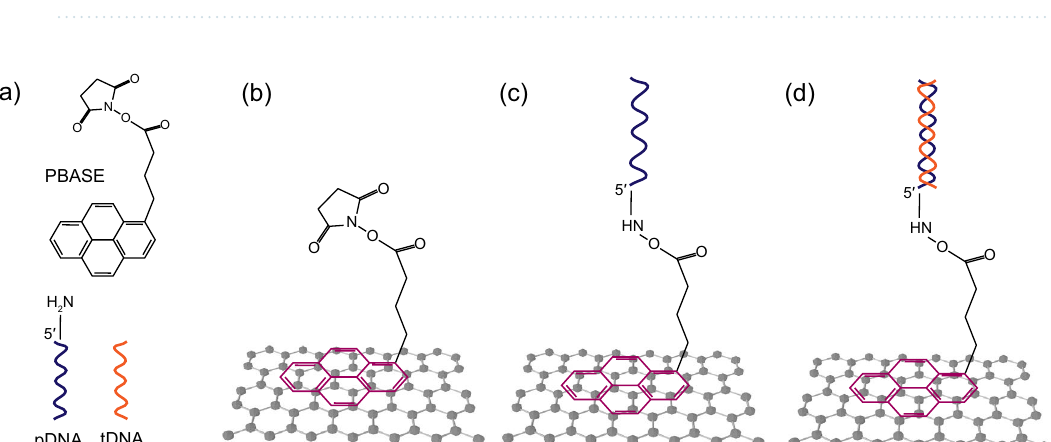
Figure 7. Conceptual drawing of the microfluidic measurement setup with the practical implementation shown in Fig. 6.